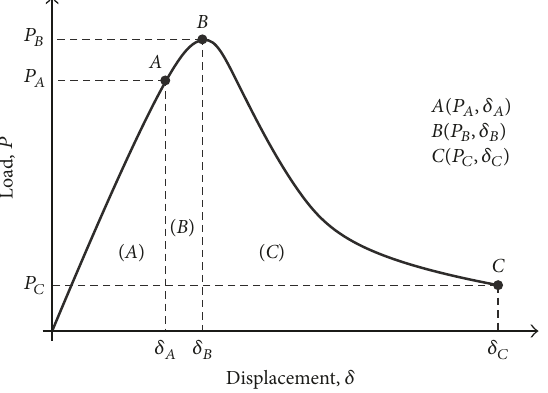
Figure 1: Typical load-displacement curve [17].